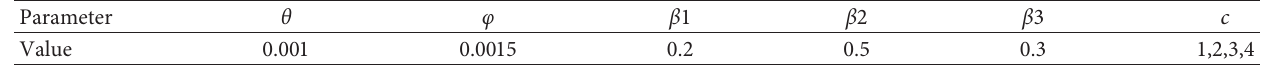
Table 1: Parameter values used in the simulation.